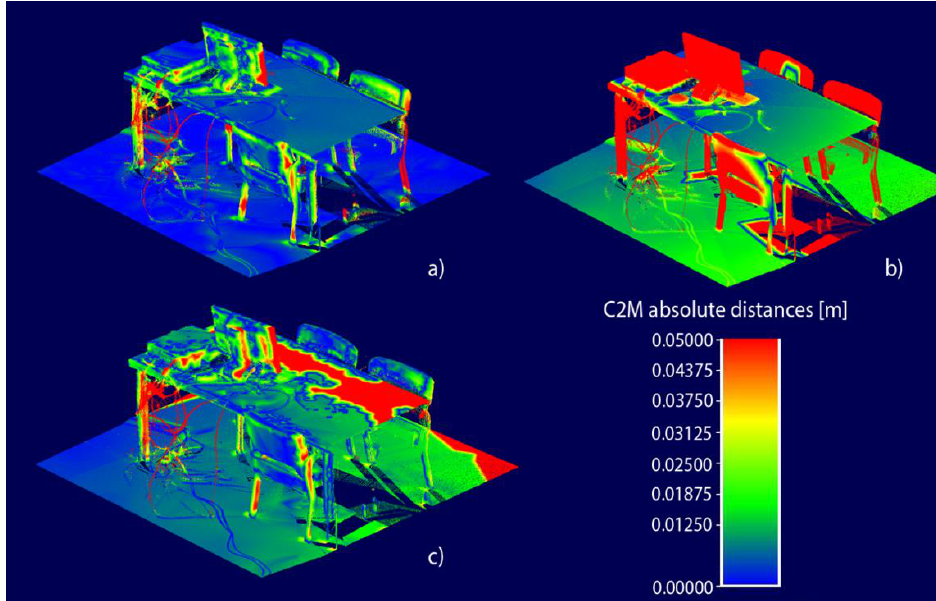
Figure 10. C2M distances of the Matterport ( a ), Theta V ( b ), and BLK360 ( c ) meshes in the hall segment. 101